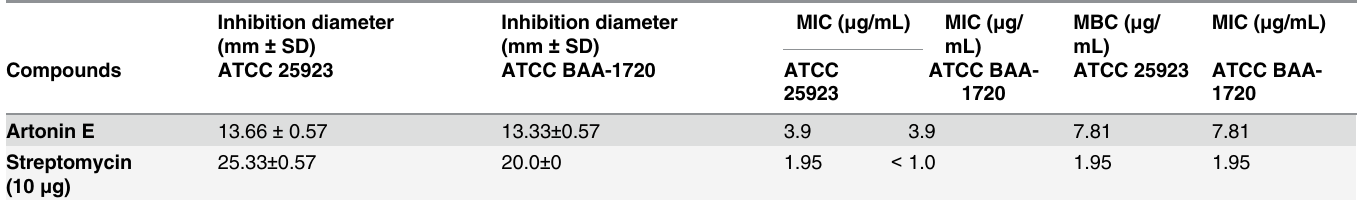
Bacterial growth inhibition was expressed in mm and measured using the disc diffusion assay. Test was performed in triplets. The mean and standard deviations are provided indicating the inhibition diameter. The MIC/MBCs of artonin E were similar for both S . aureus strains, and comparable MIC and MBCs were obtained using streptomycin. Minimum inhibitory concentration indicates that S . aureus ATCC 25923 was not grown after exposure to 3.9 μ g/ mL MIC of artonin E or 1.95 μ g/mL of streptomycin, respectively 3.9 μ g/mL MIC after the exposure of MRSA BAA-1720 to artonin E or less than 1.0 μ g/mL MIC to